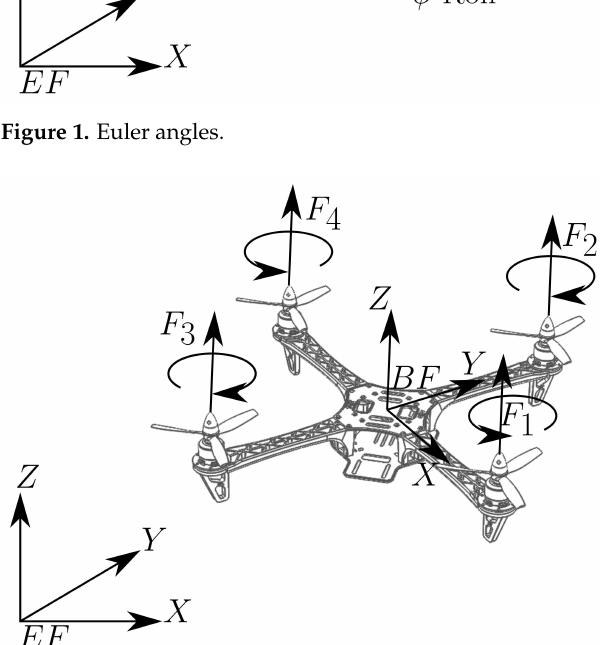
Figure 2. Forces in